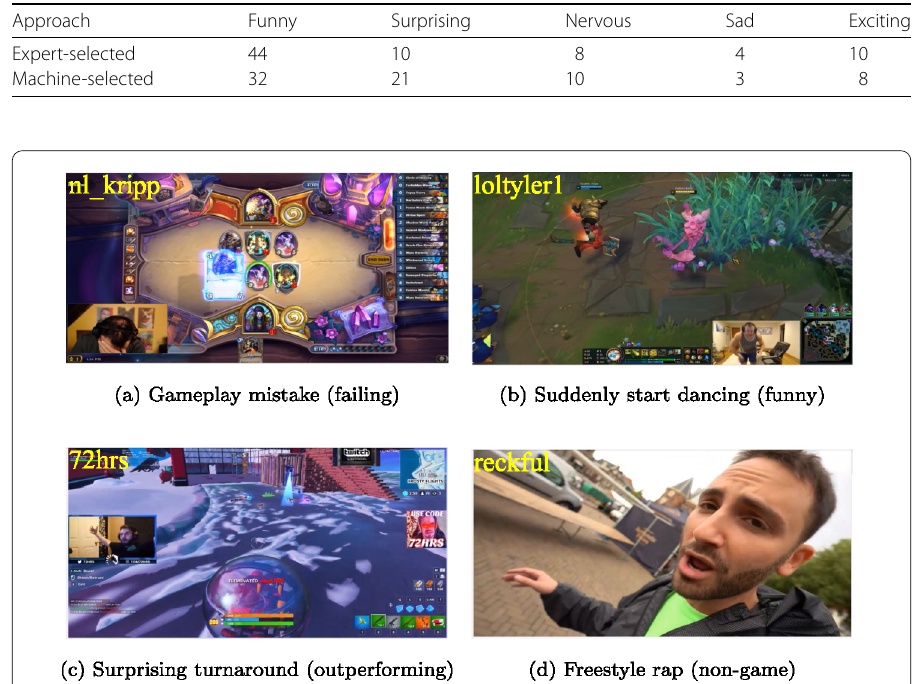
Figure 8 Example of prediction results. Our model can discover ( a ) failing, ( b ) funny, ( c ) outperforming and ( d ) non-game